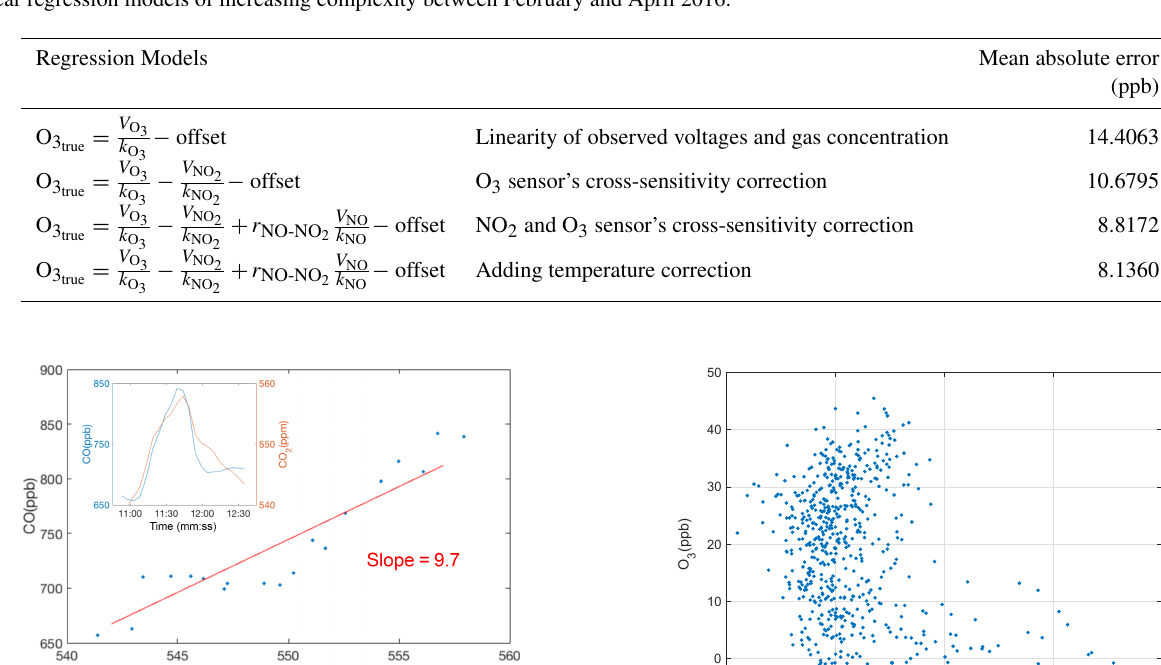
Table 3. Mean absolute error of comparison between regional O 3 and hourly averaged BEACO 2 N O 3 measurements derived from multiple linear regression models of increasing complexity between February and April 2016.